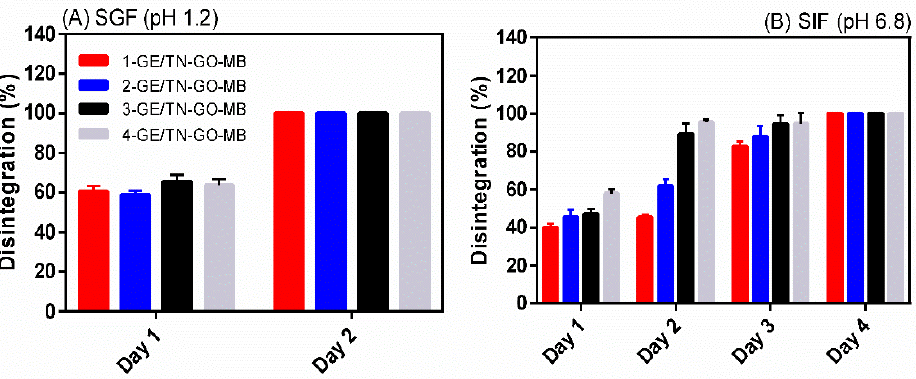
Figure 7. Disintegration results (in vitro) of GE/TN-GO-MB hydrogels in ( A ) SGF and ( B ) SIF at 37 ◦ C.